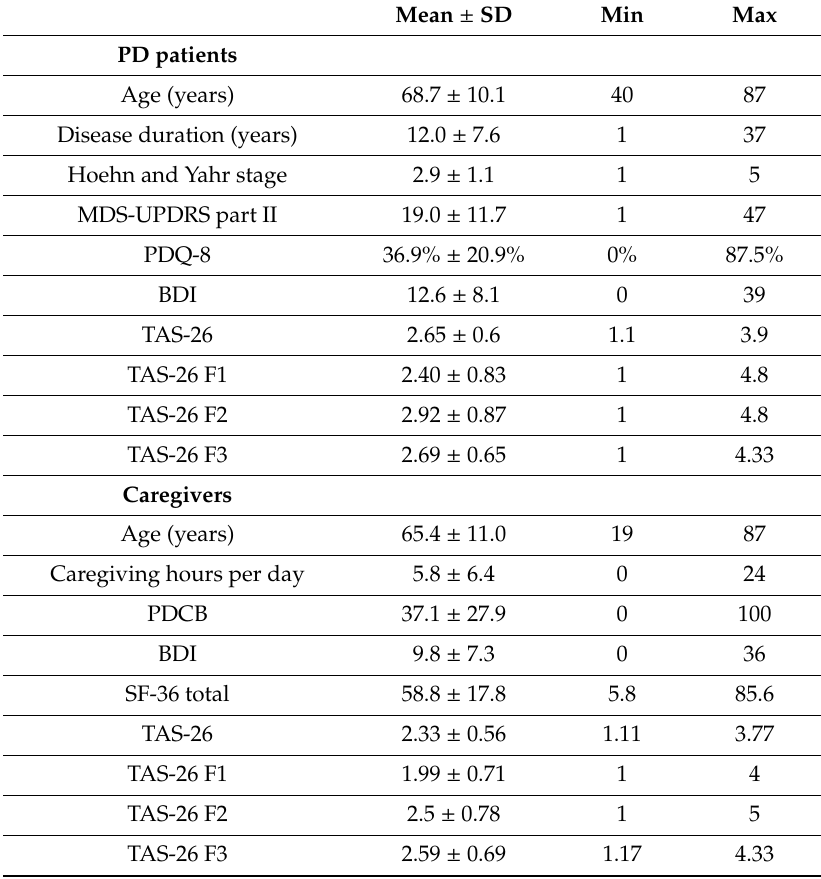
Table 1. Patient ( n = 119, 45 females) and caregiver ( n = 119, 78 females) characteristics. Mean ± SD Min